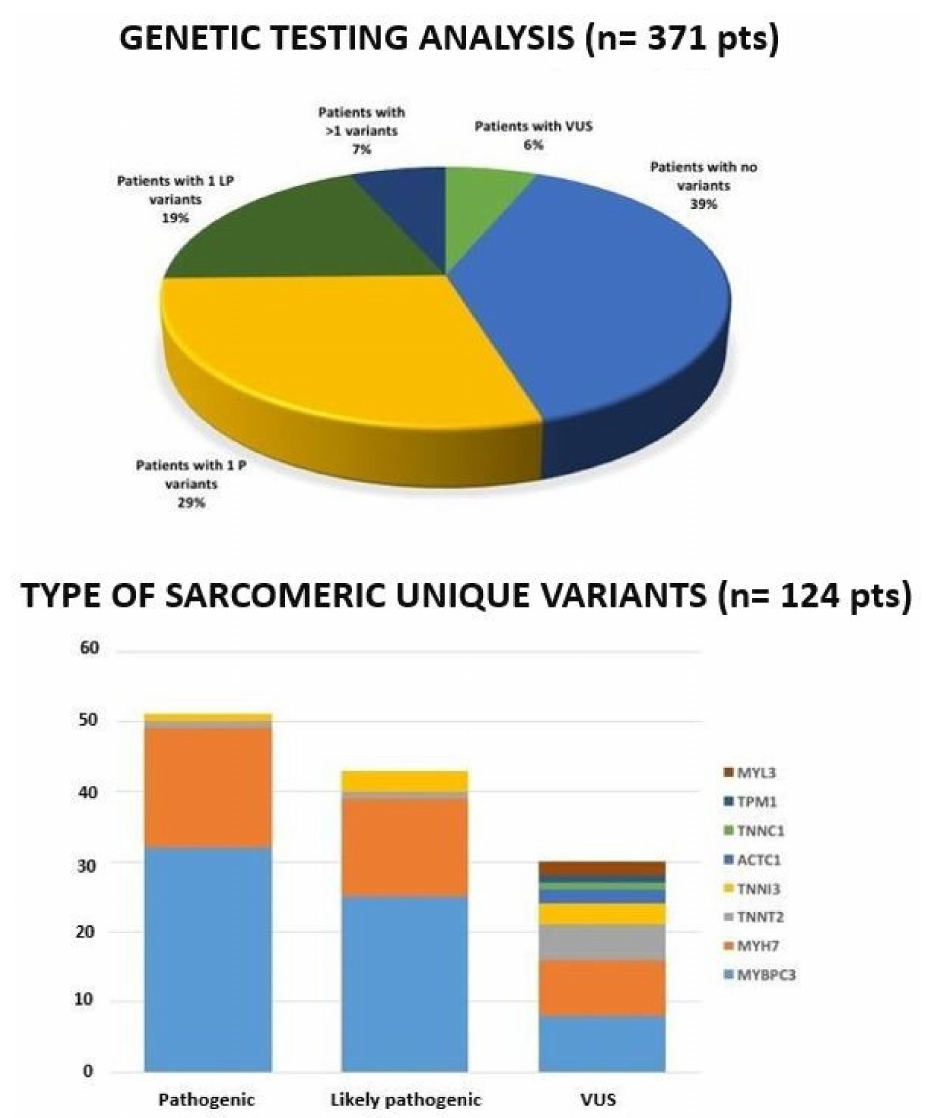
Figure 2. ( Top panel ): results of genetic testing analysis in the overall study sample. ( Bottom panel ): type and distribution of likely pathogenic / pathogenic (LP / P) variants and variants of uncertain significance (VUS). MYL3 : myosin light chain 3; TPM1 : tropomyosin 1; TNNC1 : troponin C1; ACTC1 : actin alpha cardiac muscle 1; TNNI3 : cardiac troponin I; TNNT2 : cardiac troponin T; MYH7 : β -myosin heavy chain; MYBPC3 : myosin binding protein